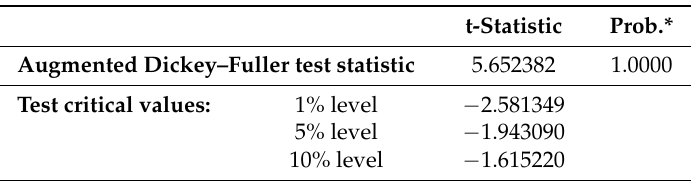
Table 6. ADF test results.